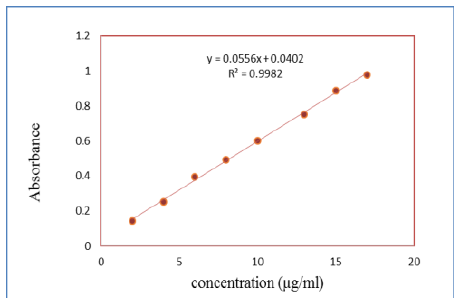
Figure (2) Calibration curve of BFN in 0.1 N HCl (pH 1.2) at λmax 220 nm Preparation of BFN microsponges Baclofen loaded microsponges were